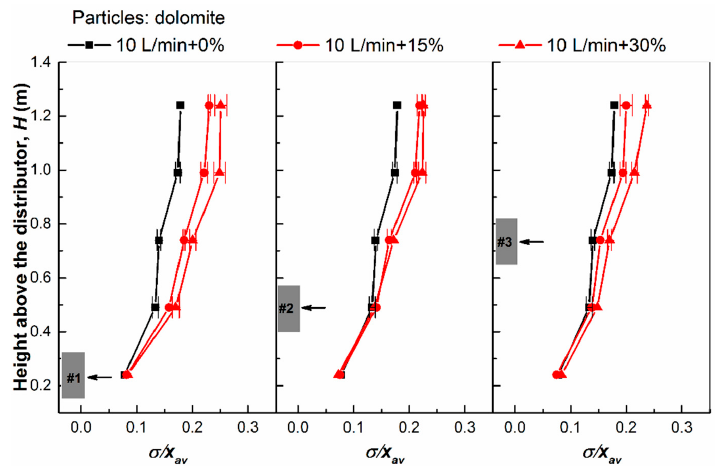
Figure 8. Effects of gas addition through porous membranes on the σ r of the differential pressure signals. The other operational conditions were: T = 550 °C, P = 0.1 MPa, H ini = 1.28 m, U = 0.09 m/s, signals. The other operational conditions were: T = 550 ◦ C, P = 0.1 MPa, H ini = 1.28 m, U = 0.09 m/s, addition rate = 1.5~3.0 L/min, calcined dolomite. addition rate = 1.5~3.0 L/min, calcined dolomite.